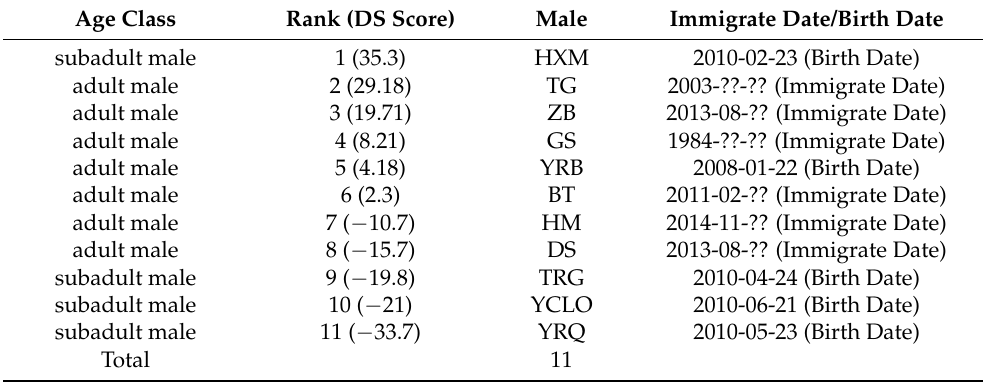
Table 1. Age class and rank of the males in the Yulingkeng A1 (YA1) group during the study period. (DS means David’s